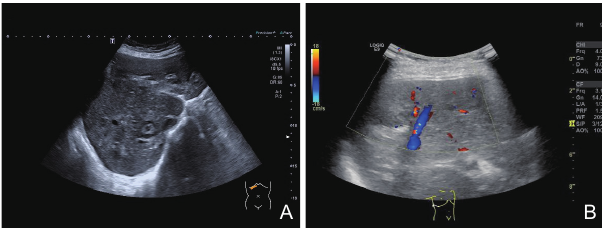
Figure 1 Routine abdominal ultrasonography. (A) Multiple hypoechoic masses spreading in the liver had an overall bull’s-eye appearance; (B) Vascular patterns were aberrant and